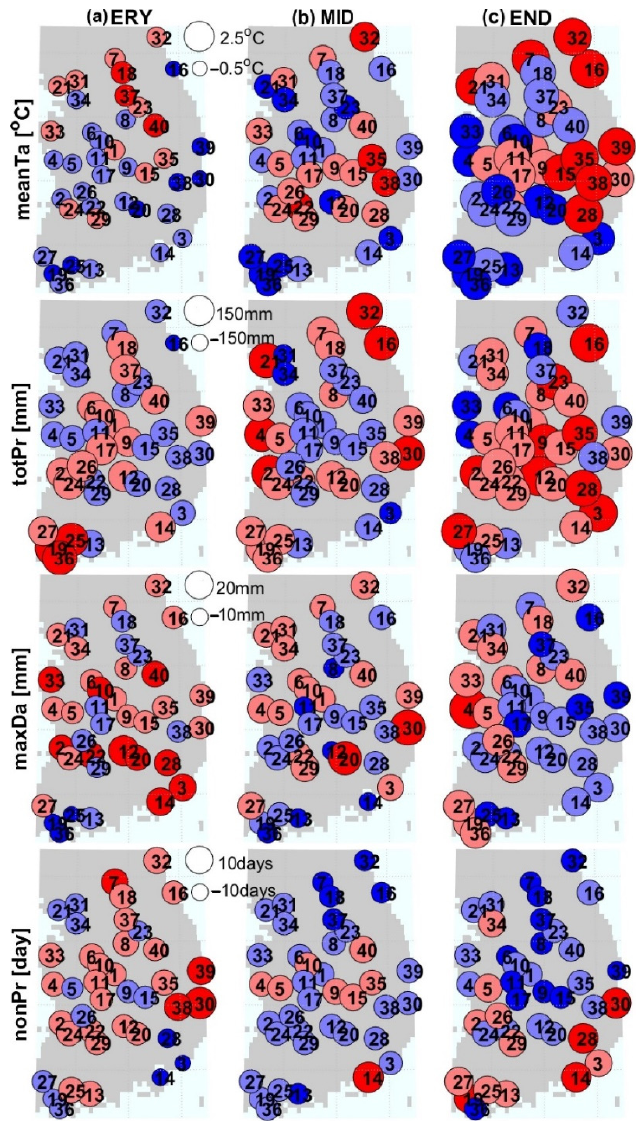
Figure 10. Spatial distribution of the UEMI values over South Korea in the ( a ) ERY, ( b ) MID, and ( c ) END periods, with the SSP5-8.5 for 4 indices computed for the whole year. In total, 40 locations are classified into 4 clusters (from the smallest cluster (dark, blue-colored circles) to the largest cluster (red colored circles)) by applying the K-means algorithm.